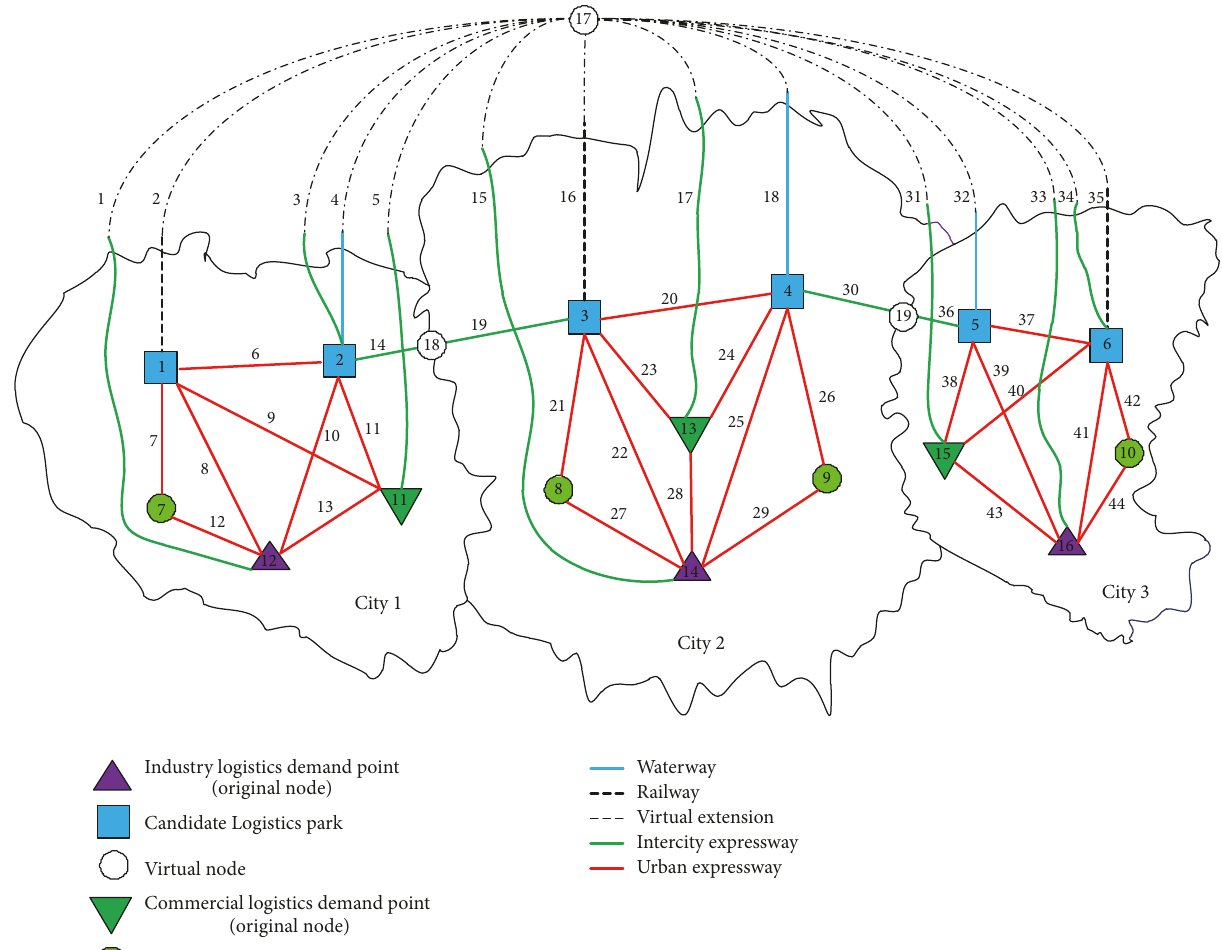
Figure 5: An example multimodal logistics network of urban